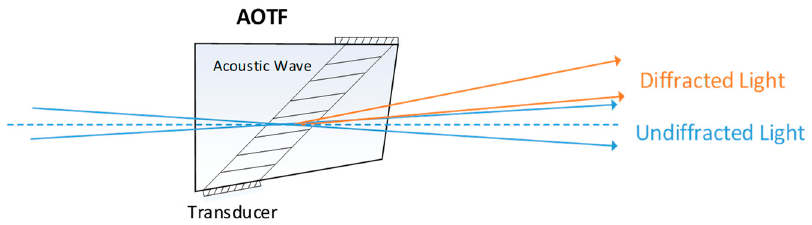
Figure 1. Principle of an acousto ‐ optic tunable filter (AOTF) device. The frequency of the acoustic wave is changed by the AOTF drive and the wavelength of diffracted light changes together.